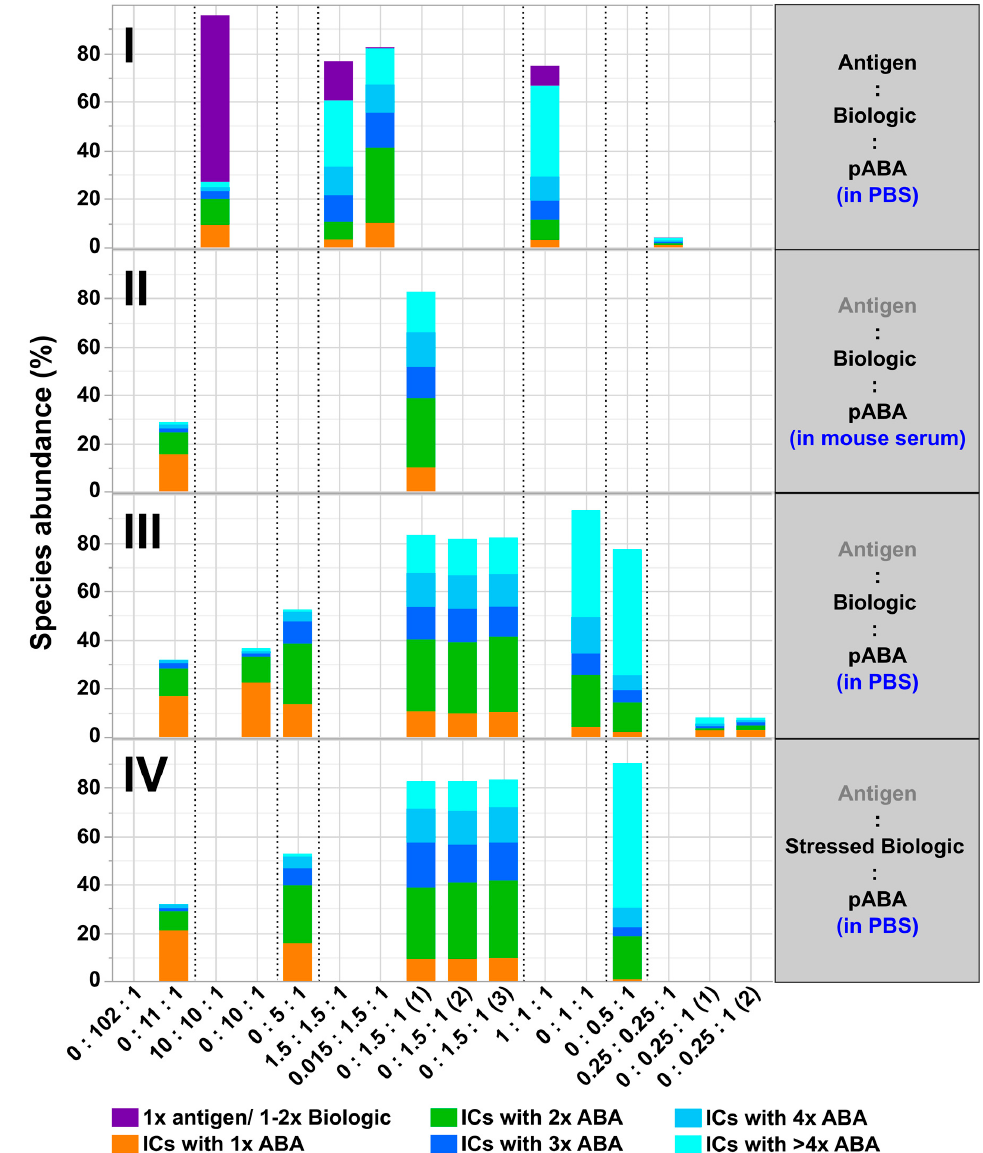
Figure 12. Quantitative SV-AUC analysis read-out assessing relative levels of formed immune complexes between antigen, biologic, and pABA. Analyzed mixtures are shown containing indicated molar ratios between biologic and pABA in the presence of the antigen in PBS background on panel ( I ), in diluted serum background on panel ( II ), in PBS on panel ( III ). Quantified immune complex amounts using stressed biologic (4 weeks at 37 ◦ C in PBS) are shown on panel ( IV ). Detected amounts of free components are not represented in the